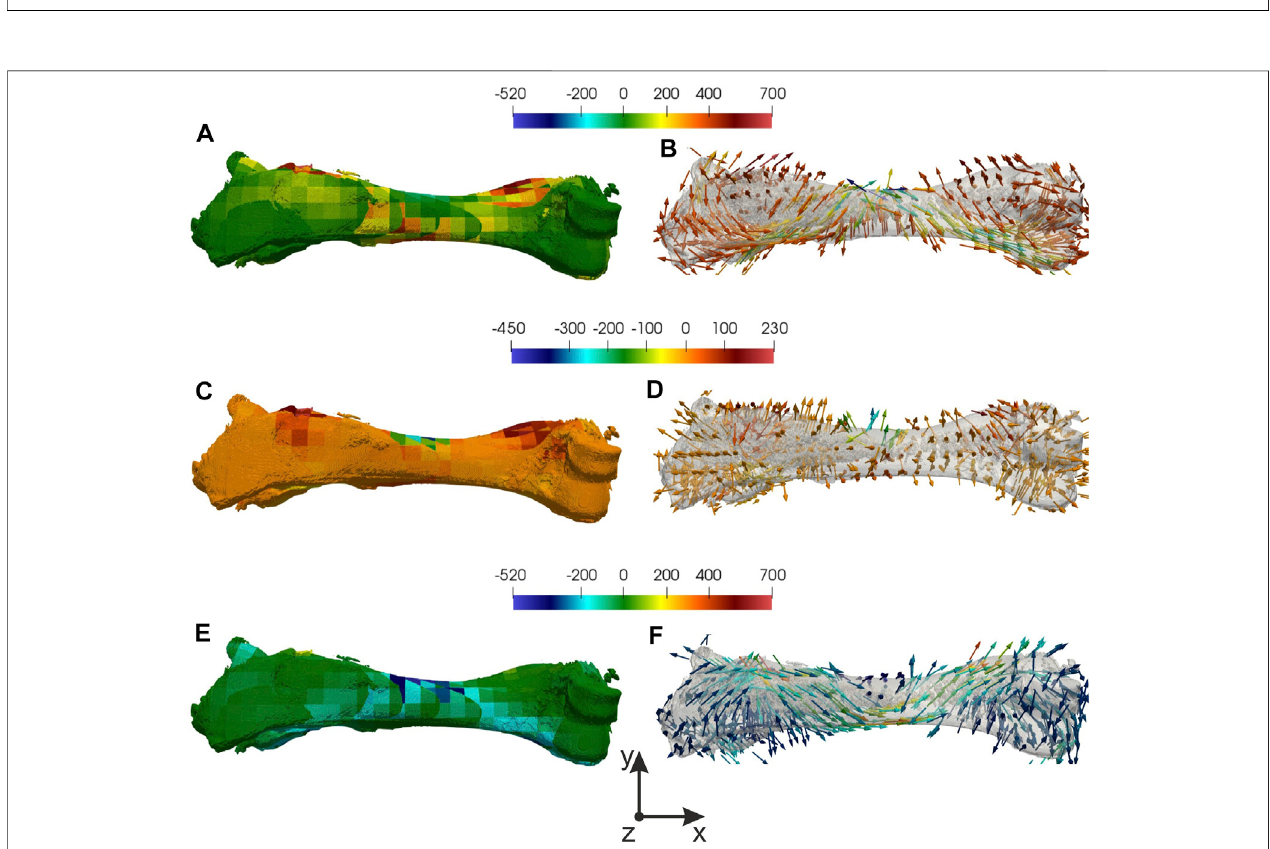
FIGURE 3 | Distribution of principal stresses and directions: (A) , (B) 1st principal stress and direction, (C,D) 2nd principal stress and direction, (E,F) 3rd principal stress and direction.